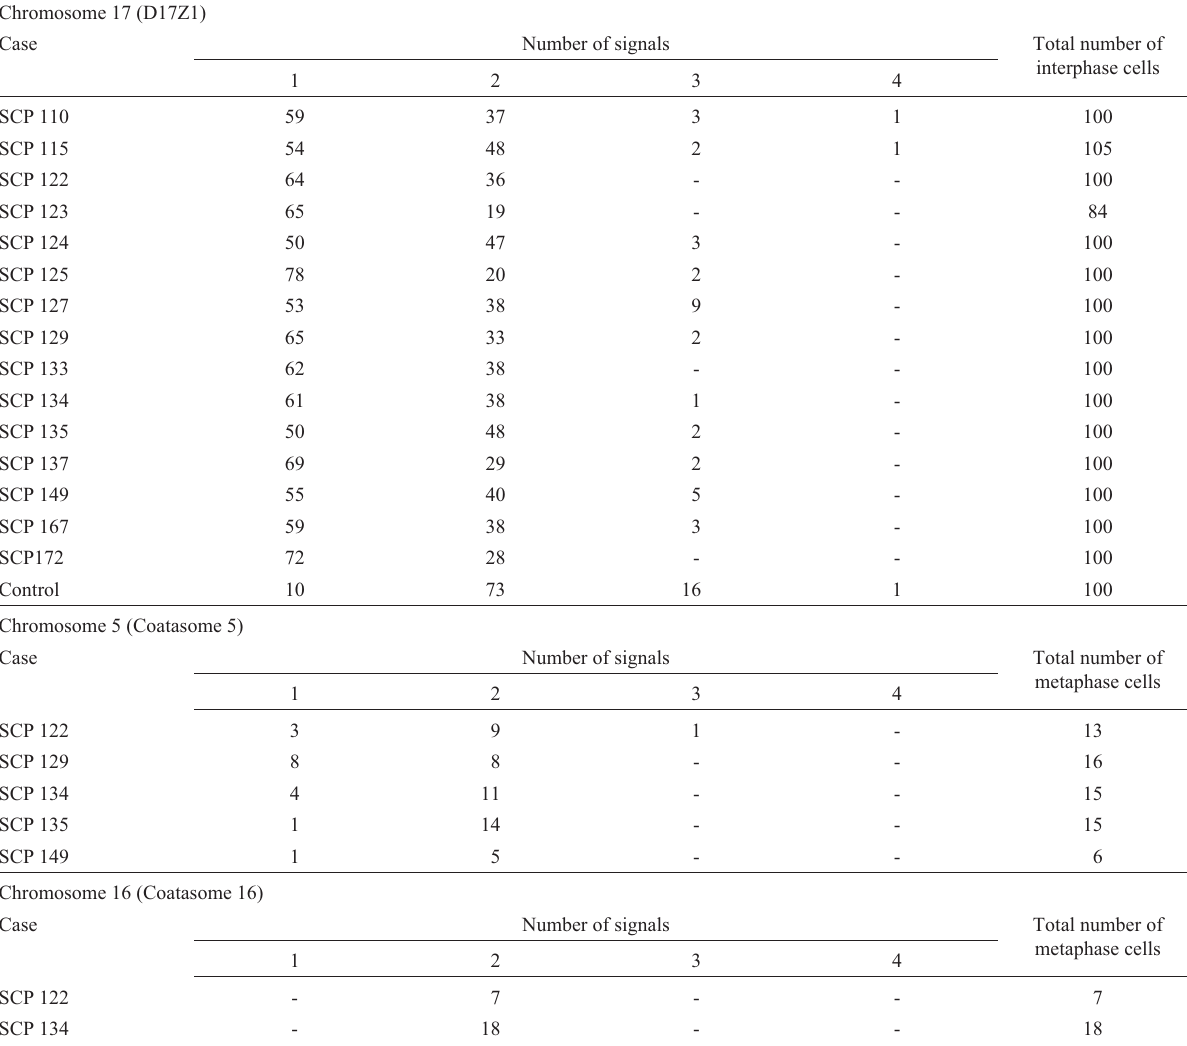
Table 2- Summary of the chromosomal aberrations detected by